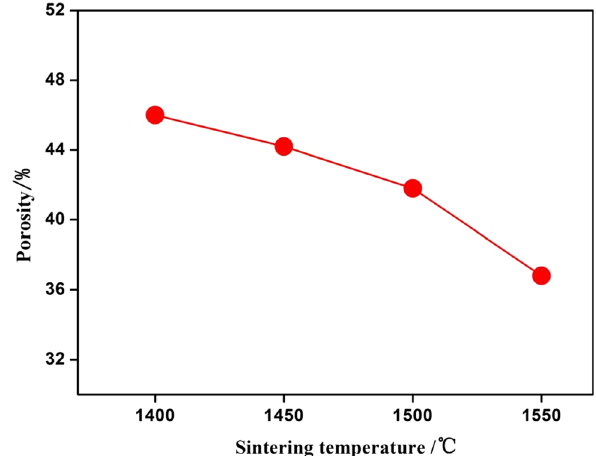
Fig. 6 Effect of sintering temperature on porosity of supports sintered at different temperatures (1400–1550